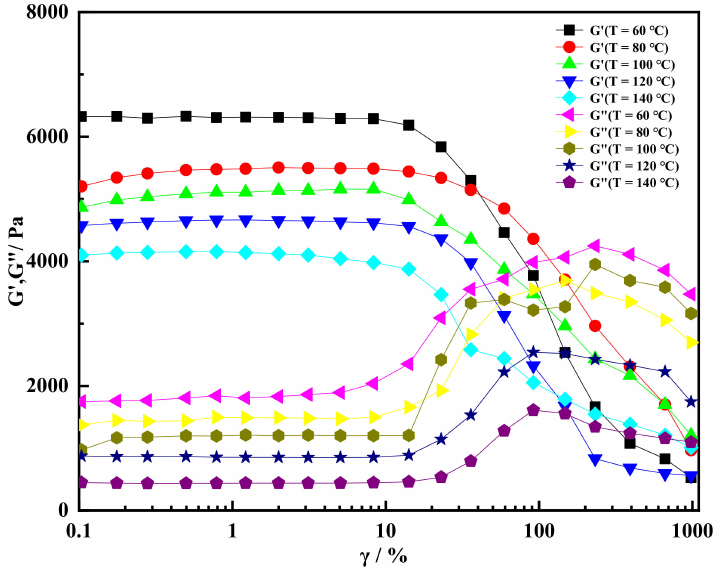
Figure 10. Storage modulus and loss modulus varied with strain at different